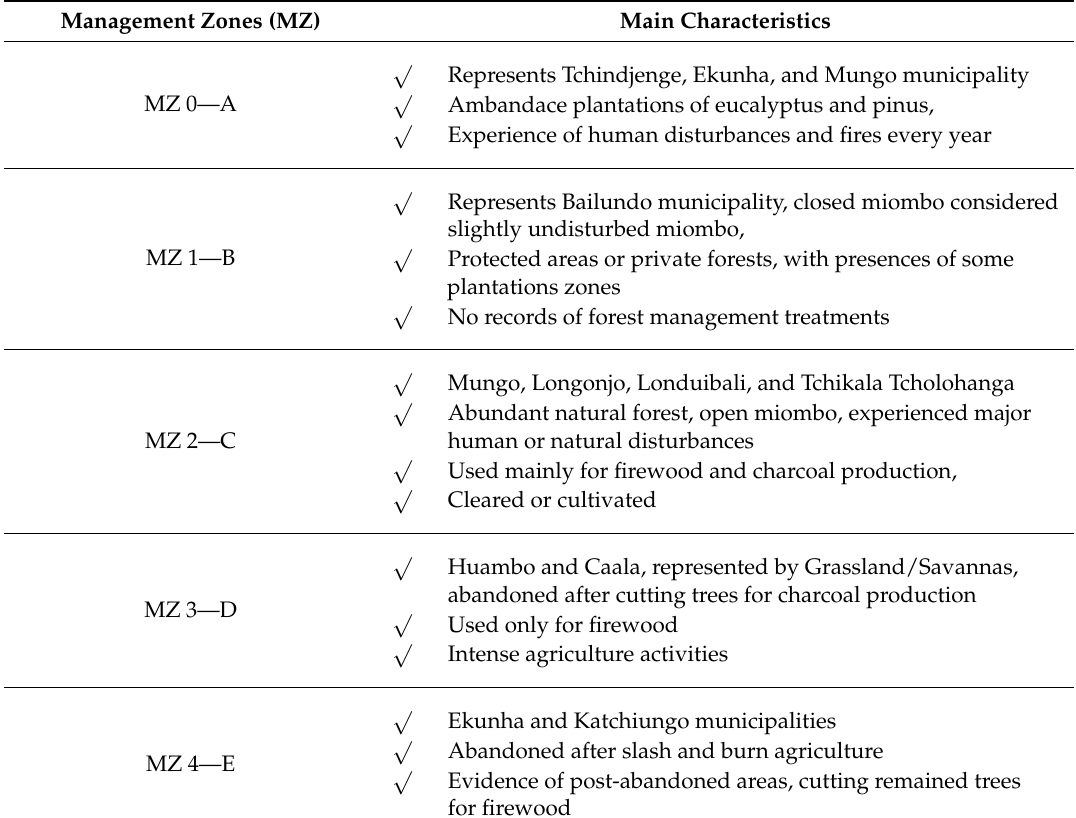
Table 6. Characterization of the suggested management